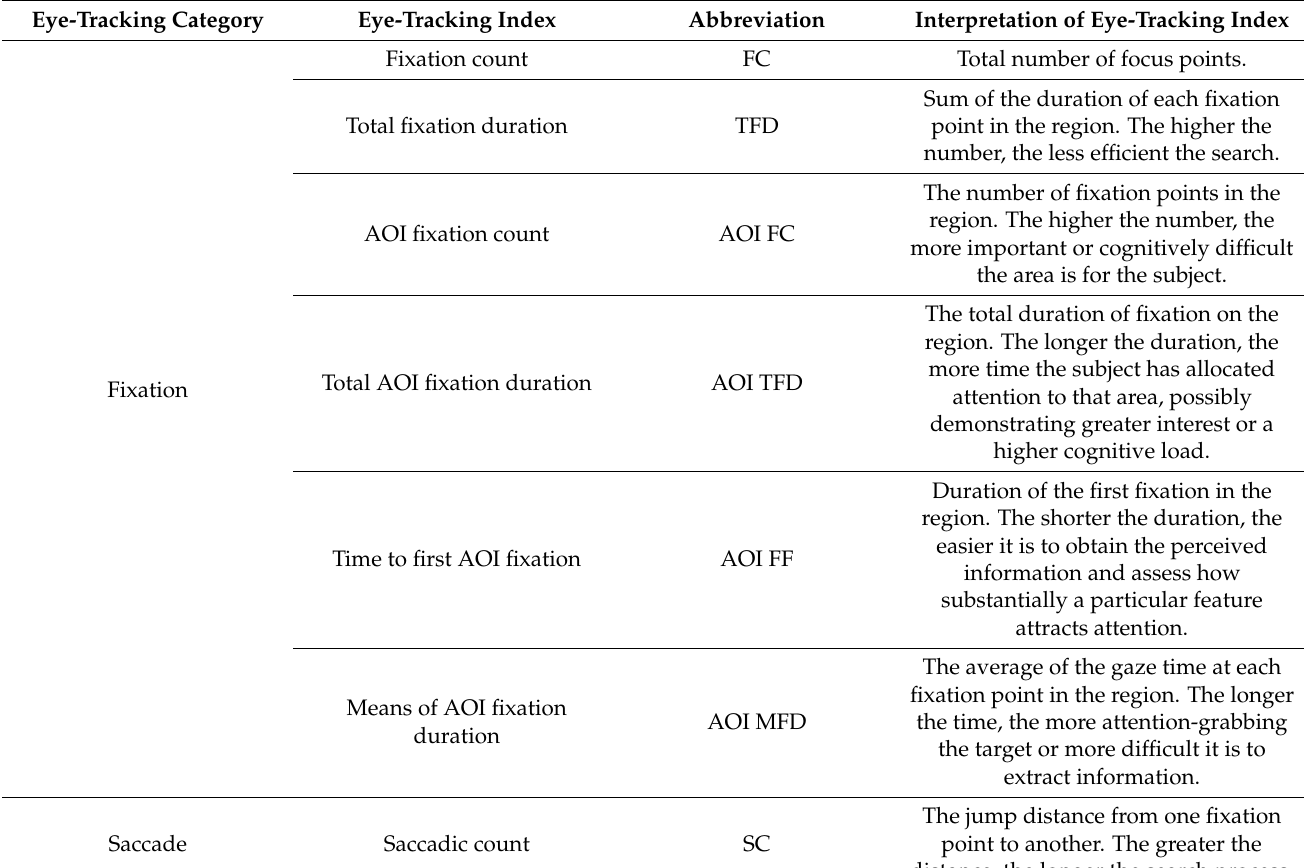
Table 1. Categories and Interpretations of Eye-Tracking